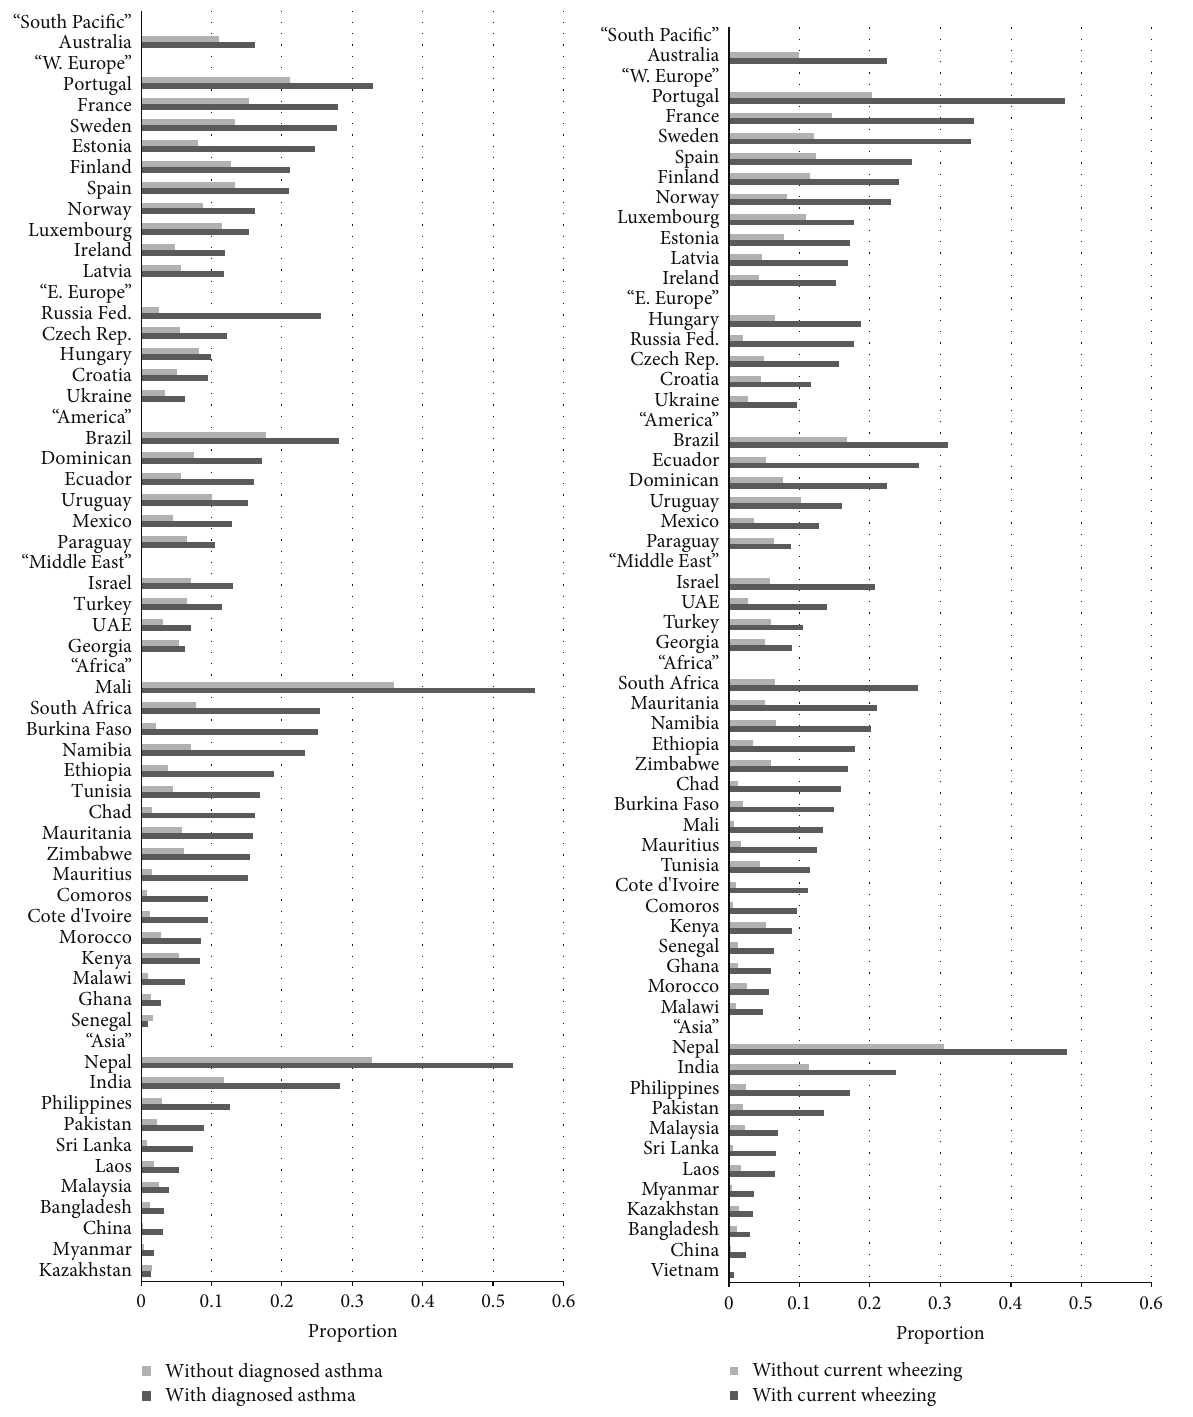
Figure 1: (a) Weighted proportions of diagnosed depression by diagnosed asthma. (b) Weighted proportions of diagnosed depression by current